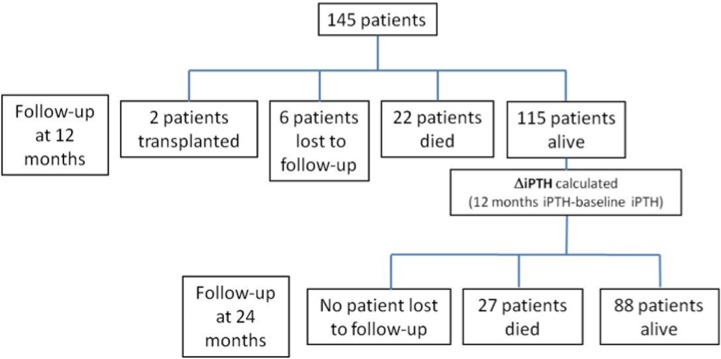
Patient flowchart.